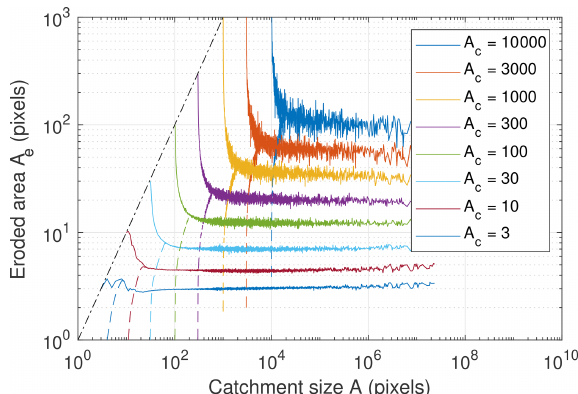
Figure 6. Ratio of total area eroded by all river segments to total area eroded by all channel head sites as a function of the fluvial threshold A c